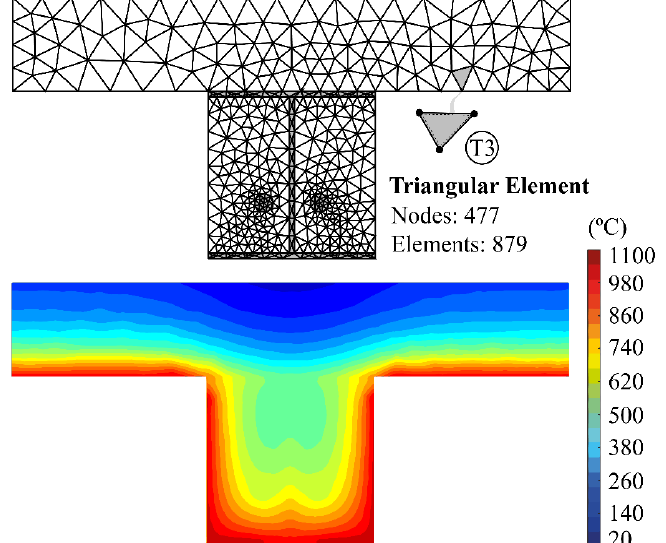
Figure 12. Finite element mesh and thermal field of the cross-section of the steel-concrete composite beam at 105 min of fire